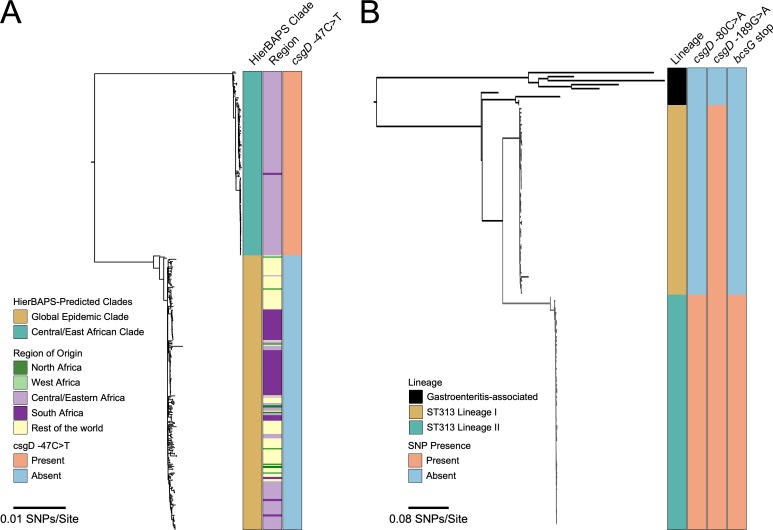
Conservation of csgD promoter and bcsG single nucleotide polymorphisms in invasive S. Enteritidis and S. Typhimurium lineages.Maximum likelihood phylogenic trees were constructed from bacterial genome sequences: (A) S. Enteritidis isolates from Feasey et al. [10], and (B) S. Typhimurium isolates from Okoro et al [48], keeping the same general tree shape for comparison purposes. (A) S. Enteritidis isolates were divided into the Central/East African clade (167 isolates) and global epidemic clade (250 isolates), with the distinct region of isolation shown along with presence or absence of the ‘T’ SNP. (B) S. Typhimurium isolates were divided into gastroenteritis-associated and invasive lineages (I and II), with the presence or absence of csgD promoter and bcsG polymorphisms shown.